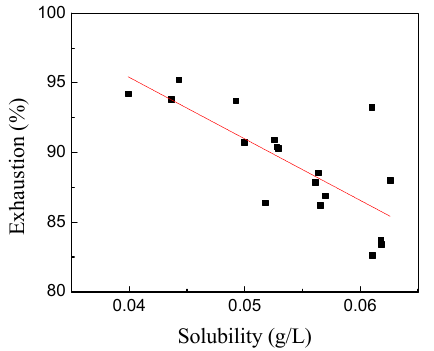
Figure 6. The relationship between the solubility of disperse dye and dye exhaustion.